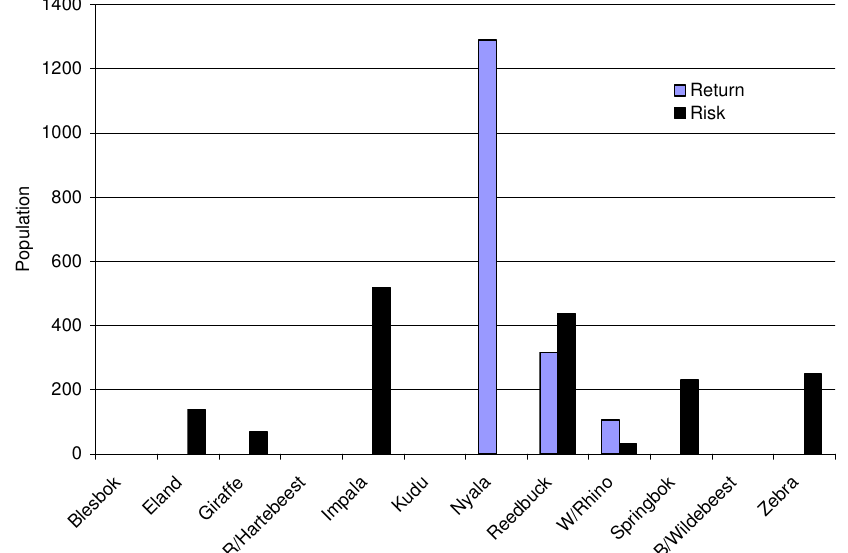
Figure 2: Populations for the two extreme cases where ‘Return’ is maximised and where ‘Risk’ is